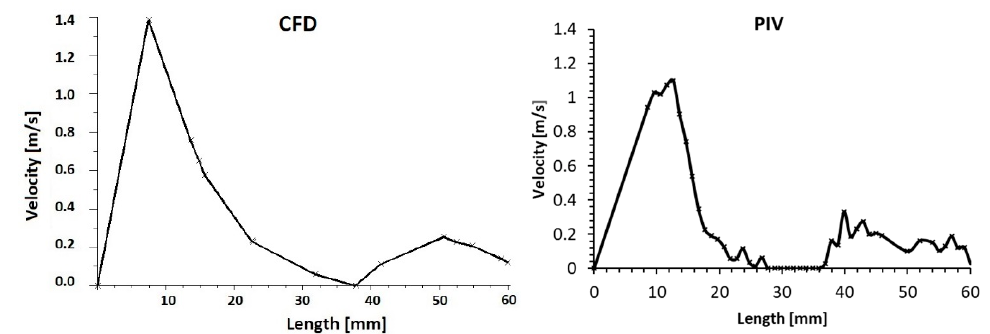
Figure 11. Velocity graphs in cross-section behind the first baffle for setting 1.